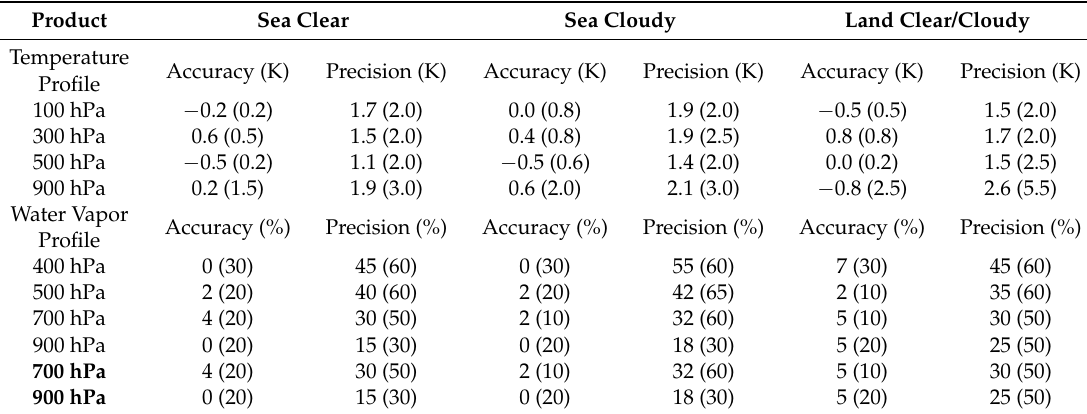
Table 12. S-NPP MiRS temperature/moisture profile performance *.